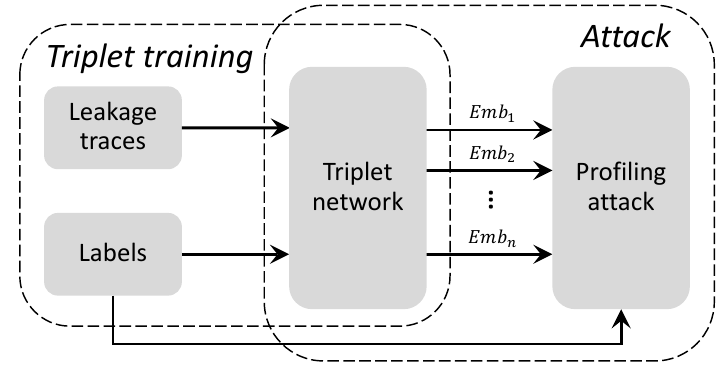
Figure 5: Triplet-assisted profiling